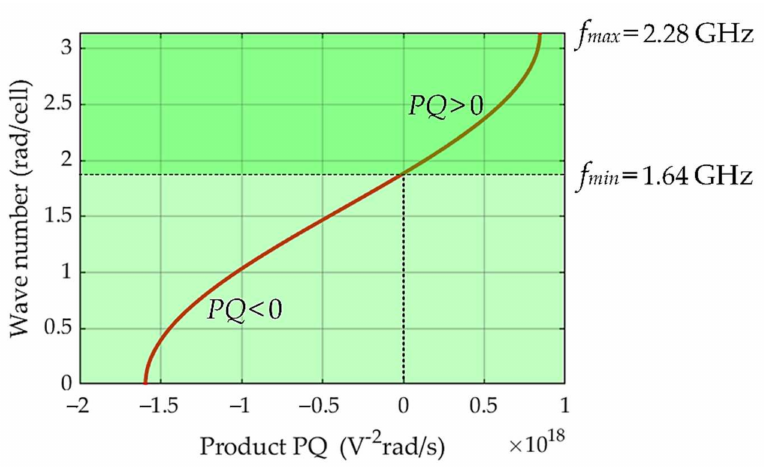
Figure 4. The wavenumber dependence of the product of the dispersion and nonlinearity coefficients PQ for lossy NLS Equation